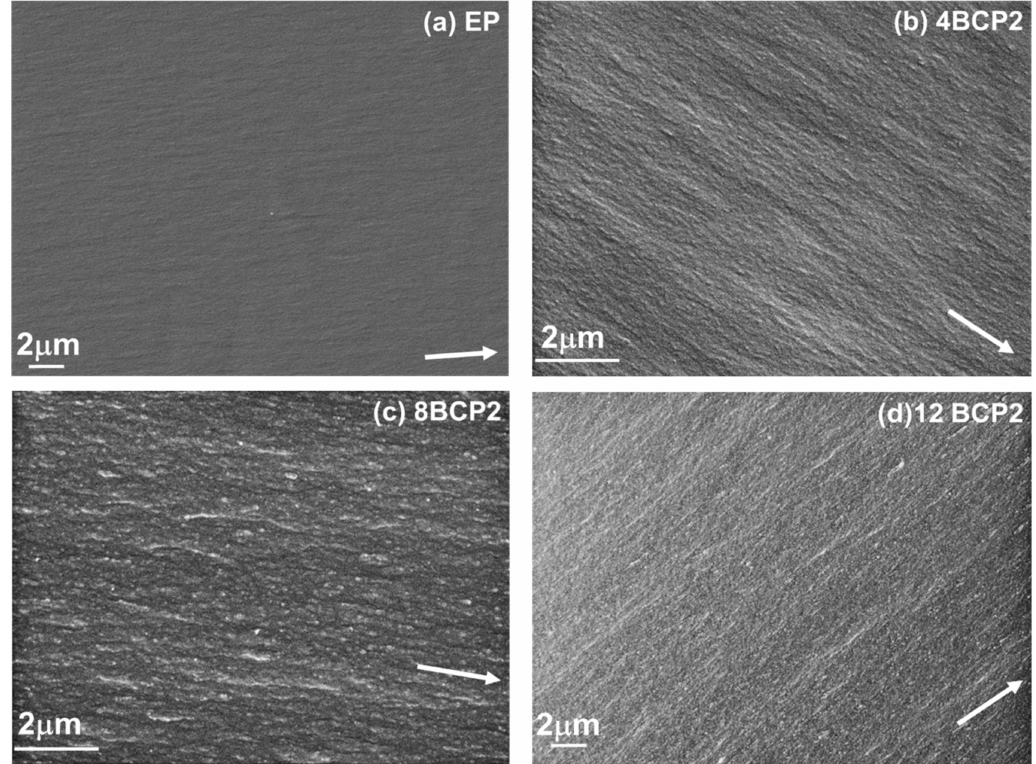
Figure 4. SEM micrograph showing the fracture surface of di ff erent epoxy systems modified with BCP2. White arrow indicates the direction of crack propagation.